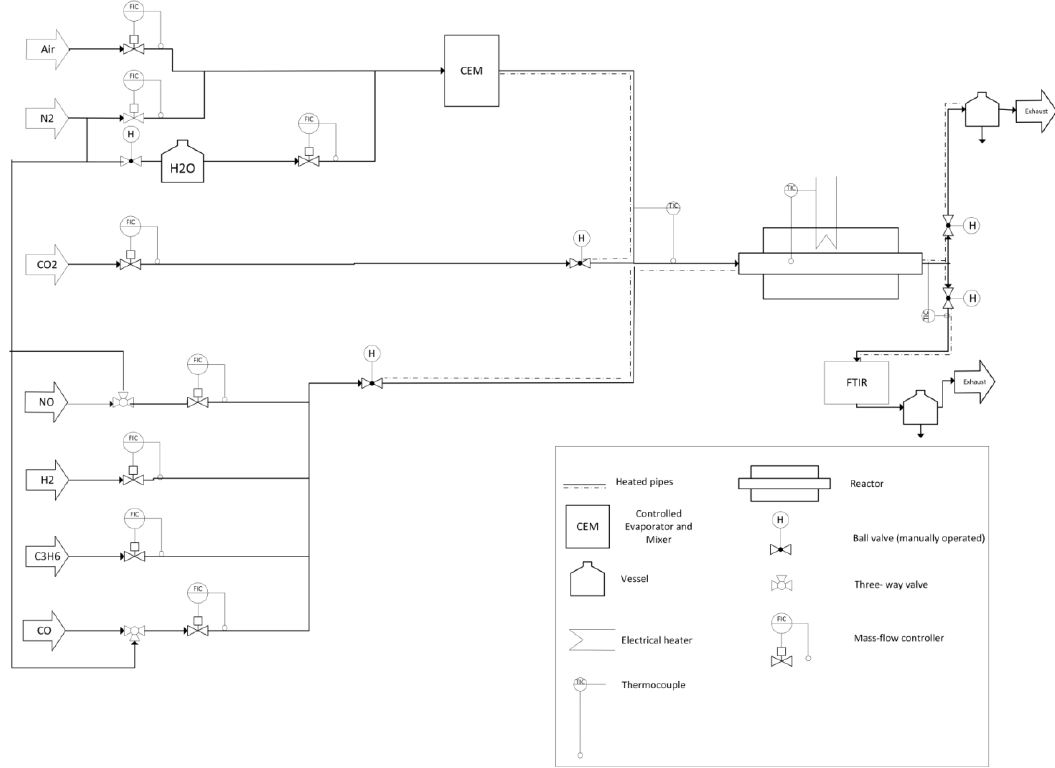
Figure 9. Schematic of the flow reactor used for activity testing.